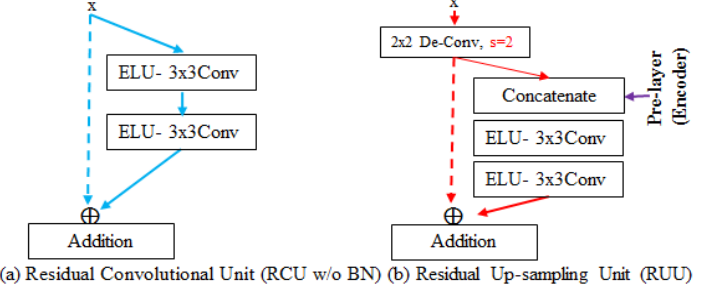
Figure 9. The decoder mainly consists of RCU without BN and RUU proposed by